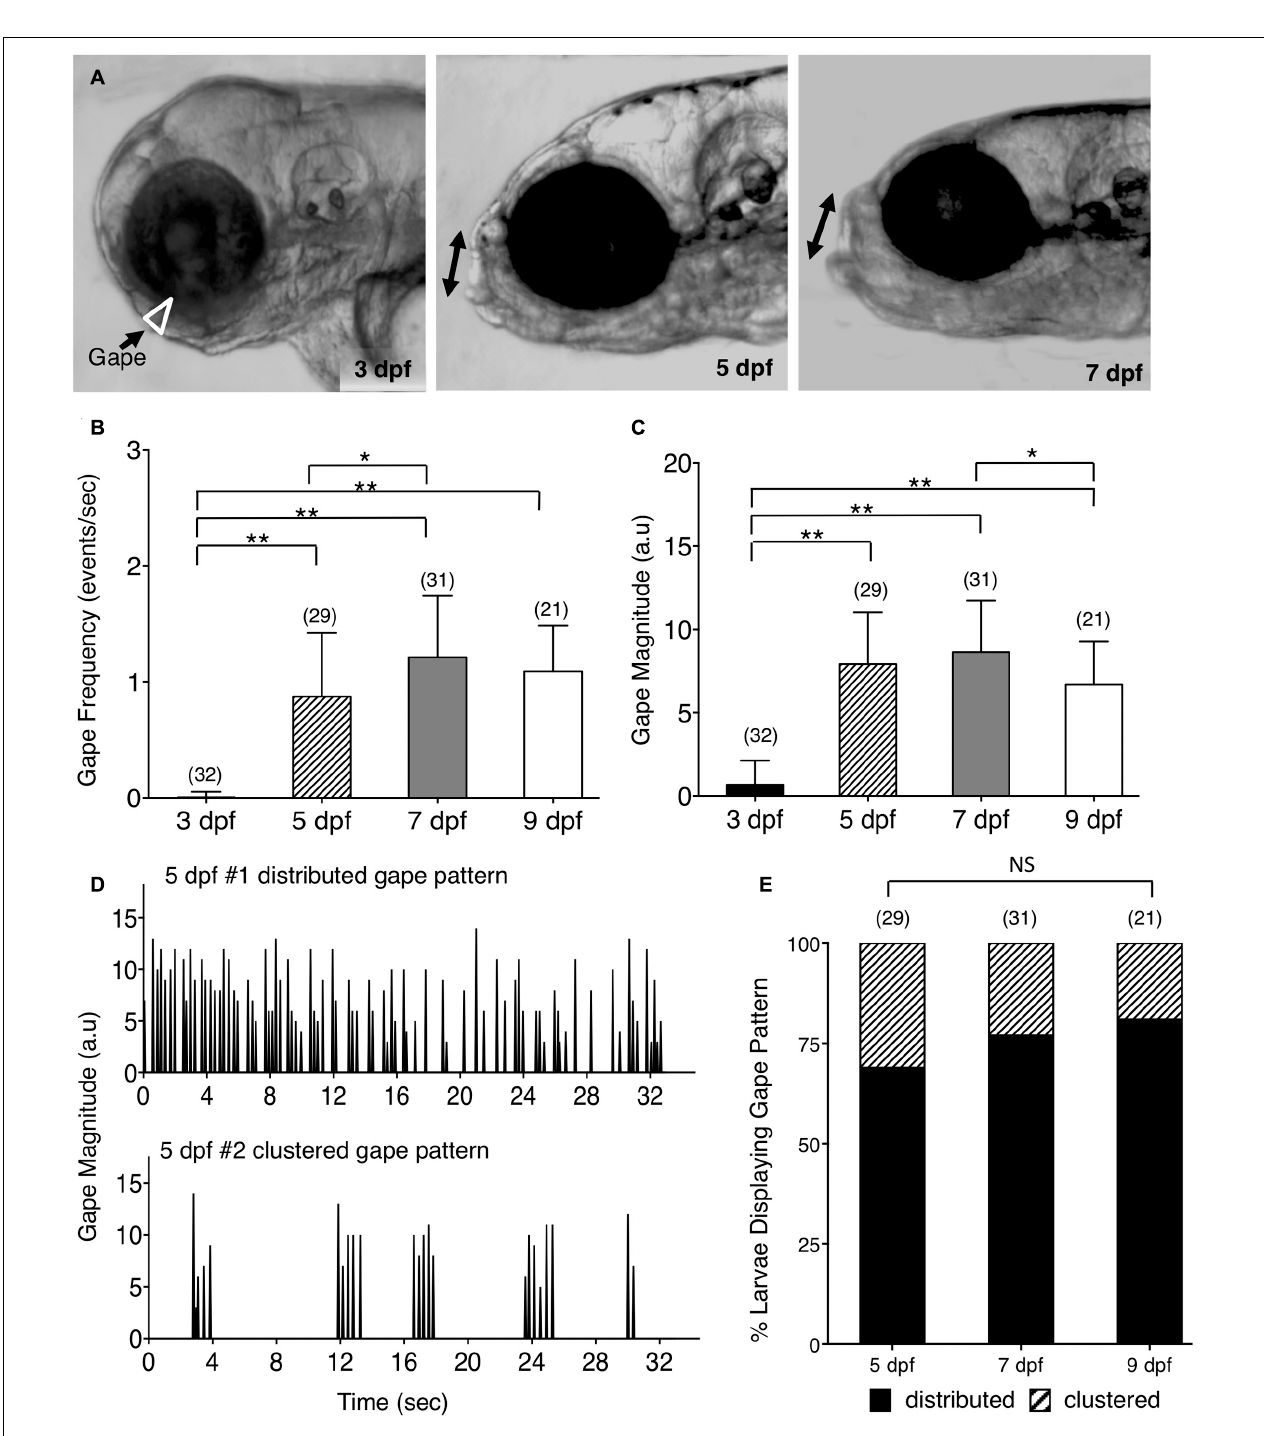
FIGURE 1 | Ontogeny of lower jaw movement in wildtype zebrafish larvae. (A) Tg ( isl1:GFP ) larvae from 3, 5, and 7 dpf were mounted in a lateral position, under a brightfield microscope, in agarose with the head free to move, and the opening of the mouth due to lower jaw movement (gape; white triangle and double arrows) was recorded and analyzed using custom software. (B,C,E) Pooled data from 3 experiments (number of larvae in parenthesis). (B) Gape frequency, increased sharply from 3 to 7 dpf, plateauing by 9 dpf. (C) Gape magnitude, a measure of the amount of jaw movement, increased sharply between 3 and 5 dpf, and plateaued thereafter. (D) There were two patterns of gape events – Distributed, with jaw movements distributed uniformly throughout the observation period, and Clustered, with tightly clustered jaw movements with intervals of inactivity. (E) The distributed gape pattern was predominant at every age examined, and there was no significant difference between 5, 7, and 9 dpf. Statistical analysis was carried out with Chi-square test and One-way analysis of variance (ANOVA) with post hoc Tukey’s HSD (honest significance difference). NS, not significant, * p < 0.05, ** p < 0.01.